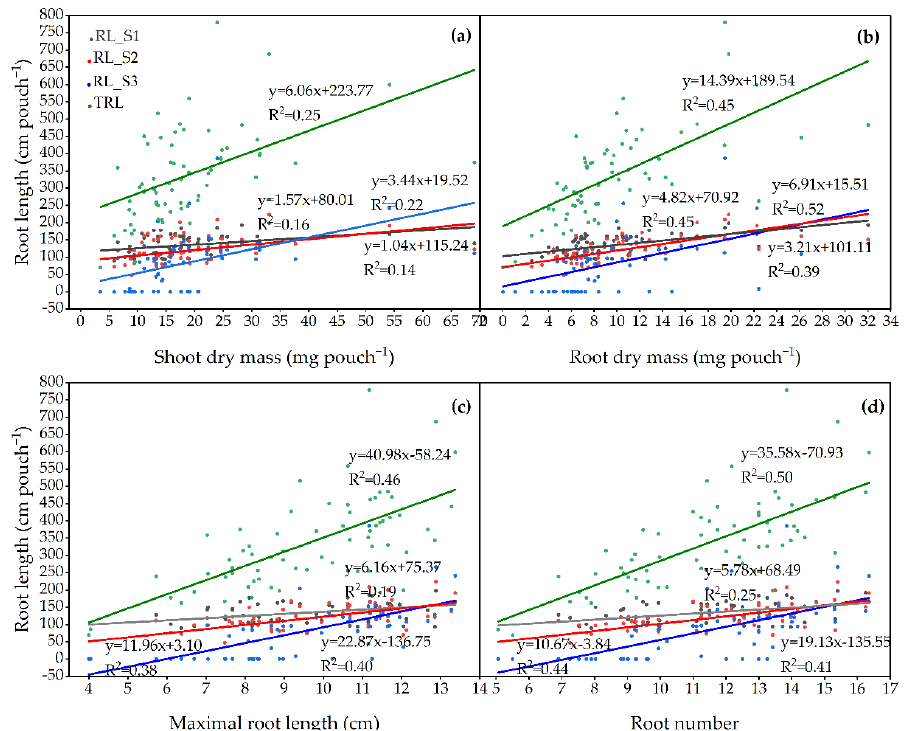
Figure 5. Linear fitting of root phenotypic characteristics: ( a ) root length vs. shoot dry mass; ( b ) root length vs. root dry mass; ( c ) root length vs. maximal root length; ( d ) root length vs. root number. Total root length (TRL) and root length in three sections (RL_S1, RL_S2, RL_S3) were used in the analysis.